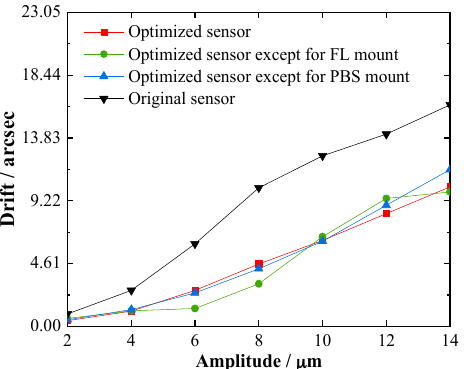
Figure 12. Drifts when a vertical vibration was applied.